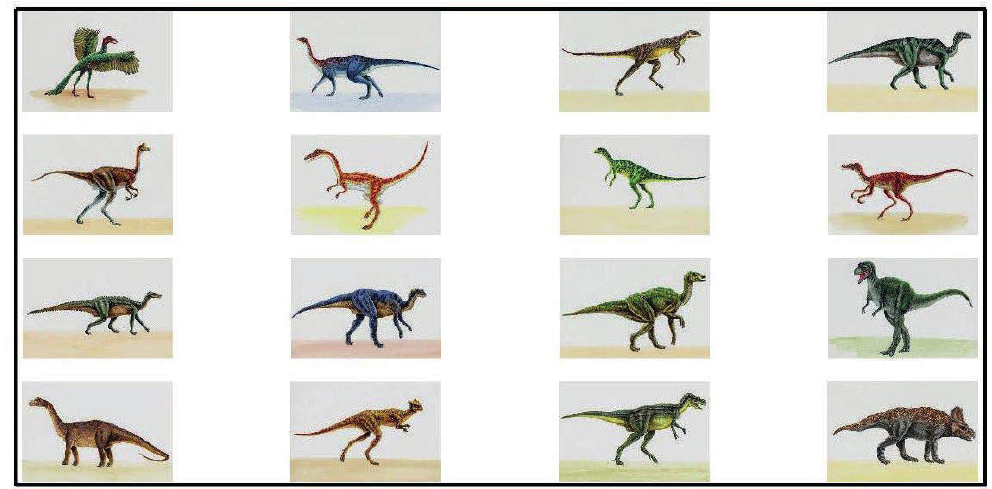
Fig. 10. Dinosaur images retrieved using K-Means based CBIR.